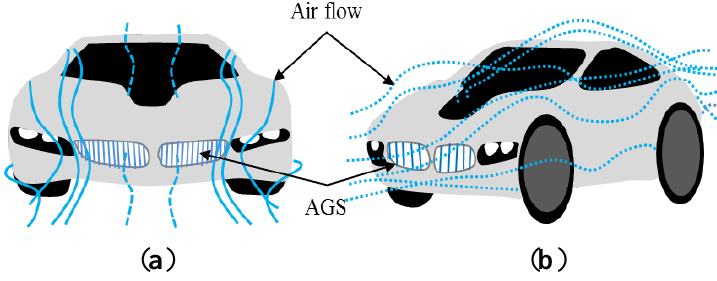
Figure 1. Air-flow concept in AGS. ( a ) Flap ON . ( b ) Flap OFF .